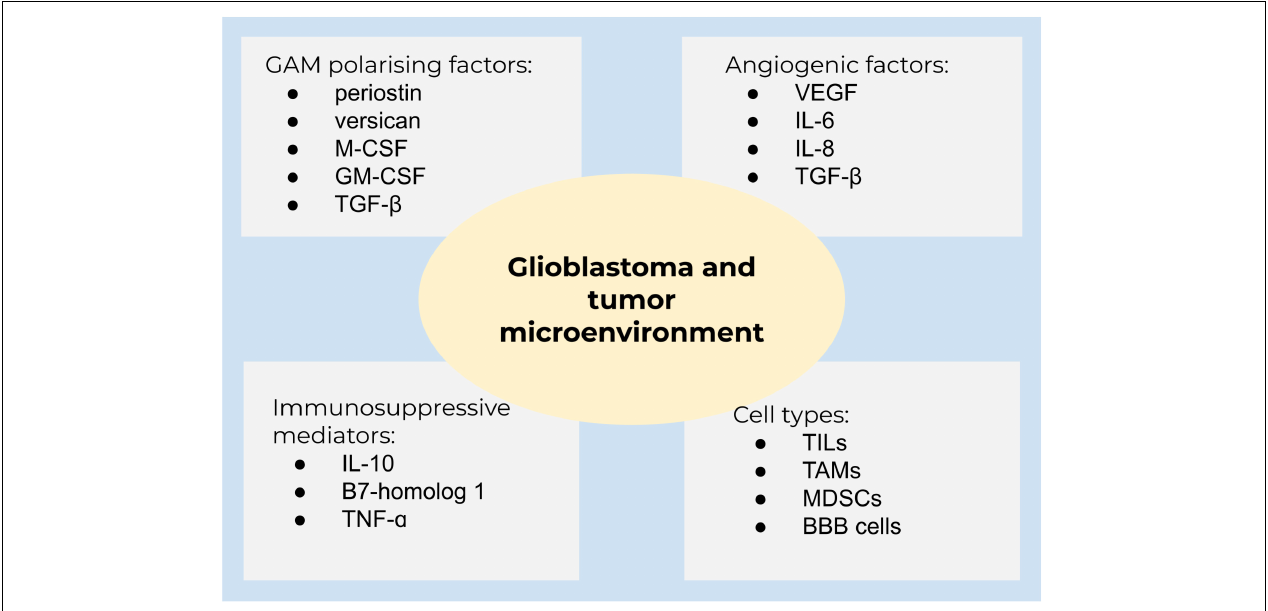
FIGURE 3 | Glioblastoma and the tumor microenvironment. A summary of main components of the tumor microenvironment in glioblastoma.